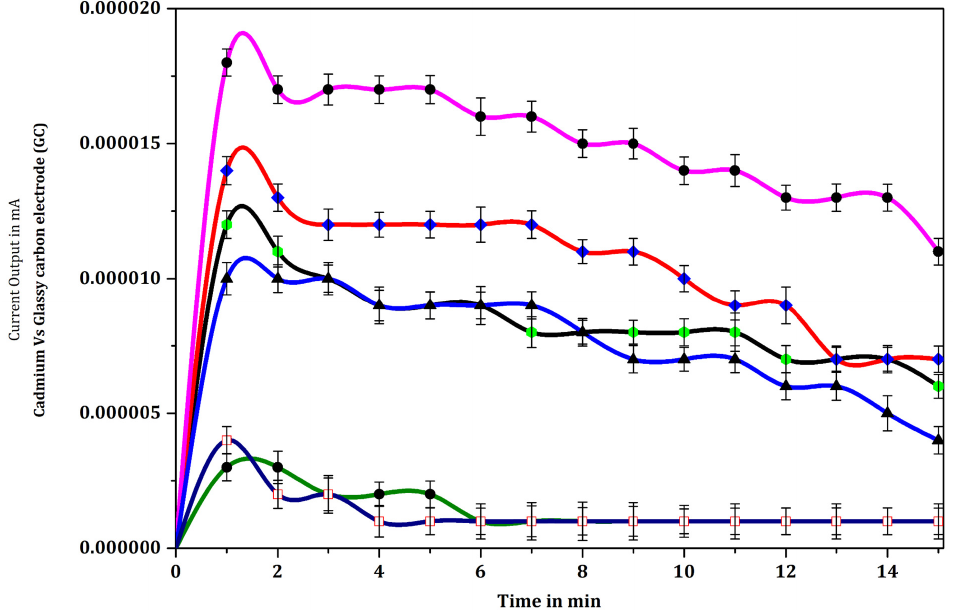
Figure 11. Response signal output current curves of glassy carbon electrode with phosphate buffer solution (PBS ) and immobilized mouse anti- Salmonella monoclonal antibody (MCA) (1:30,000 dilution) with various concentrations of Salmonella cells [MCA-S.Ag 3 × 10 3 cells/mL ( ), 3 × 10 4 cells/mL ( ), 3 × 10 5 cells/mL ( ), 3 × 10 6 cells/mL ( ), and 3 × 10 7 cells/mL ( )] with MCA-S.Ag-S.mAb-HRP-O-Ap reaction in 0.1 M PBS solution. Data represent mean ± SD (n = 5). Table 4. Optimization of cells in different concentration for sensor application. p -value for each pair of data analyzed using one-way ANOVA. The significance value (0, 1) provided in parenthesis be- side the p -value denotes the significance of each pair of data. The significance value 1 indicates that the data pairs are significantly different ( p -value lesser than 0.05). The significance value 0 depicts that the data pairs are not significantly different ( p -value greater than 0.05).